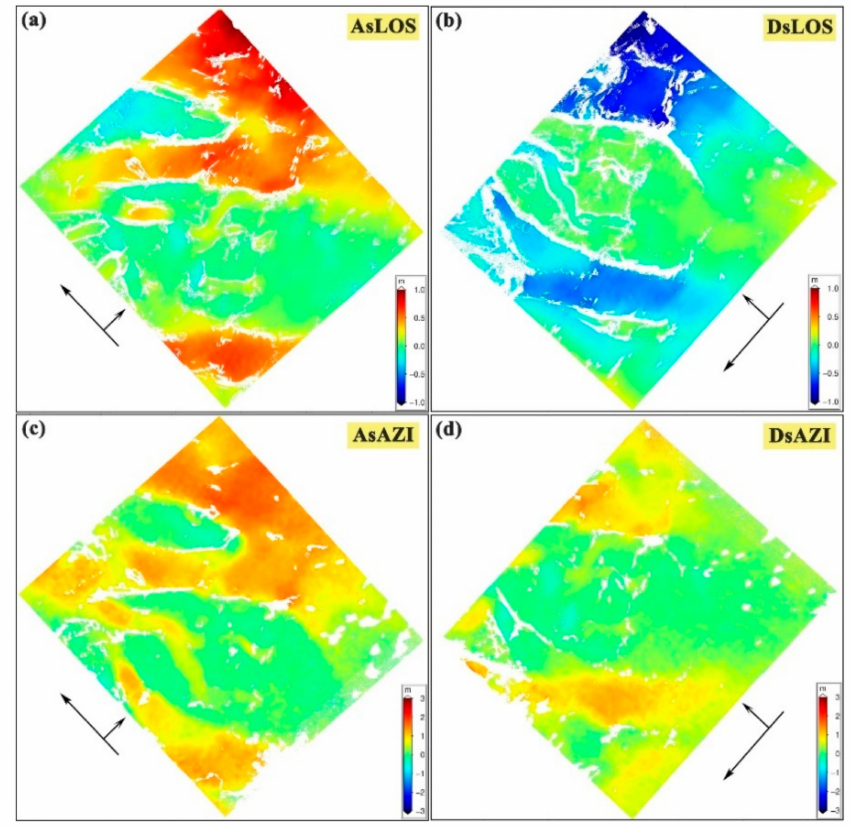
Figure 4. Observations for retrieving 3D ice velocities. ( a , b ) are the DInSAR line-of-sight (LOS) measure- ments after baseline-combination processing from the ascending and descending tracks, respectively.